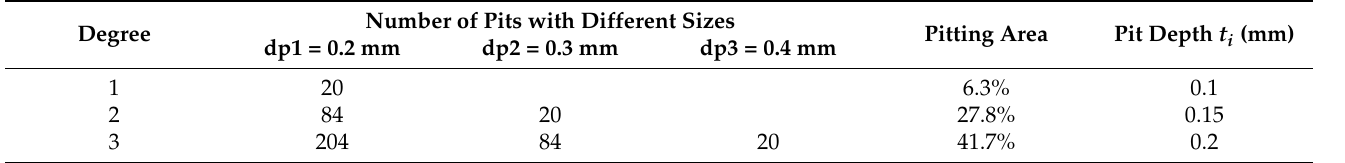
Table 2. Pitting degree